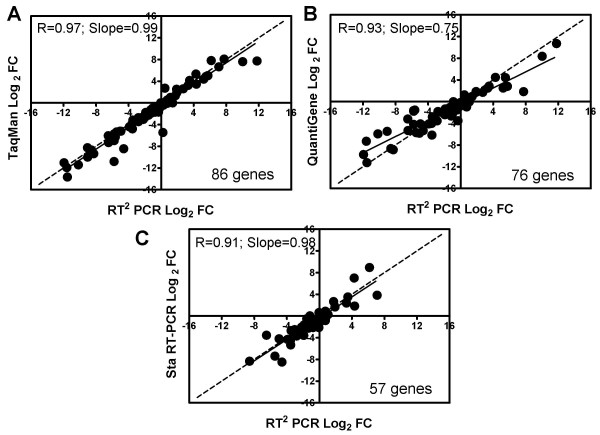
Cross-platform comparison between SYBR Green RT2 Profiler PCR Arrays and the three quantitative platforms. The concordance of fold-changes between the PCR Arrays and the three quantitative platforms was evaluated by regression analysis of fold differences in sample B compared to sample A. Data were normalized against POLR2A for RT2 Profiler PCR Arrays and TaqMan, and against beta-actin for StaRT-PCR. The sample B/sample A (B/A) fold changes (log2) for each gene common between RT2 Profiler PCR Arrays and another platform were subjected to bivariate analysis. The dashed line on each graph represents the ideal slope of 1.0. The solid lines show a linear regression fit.